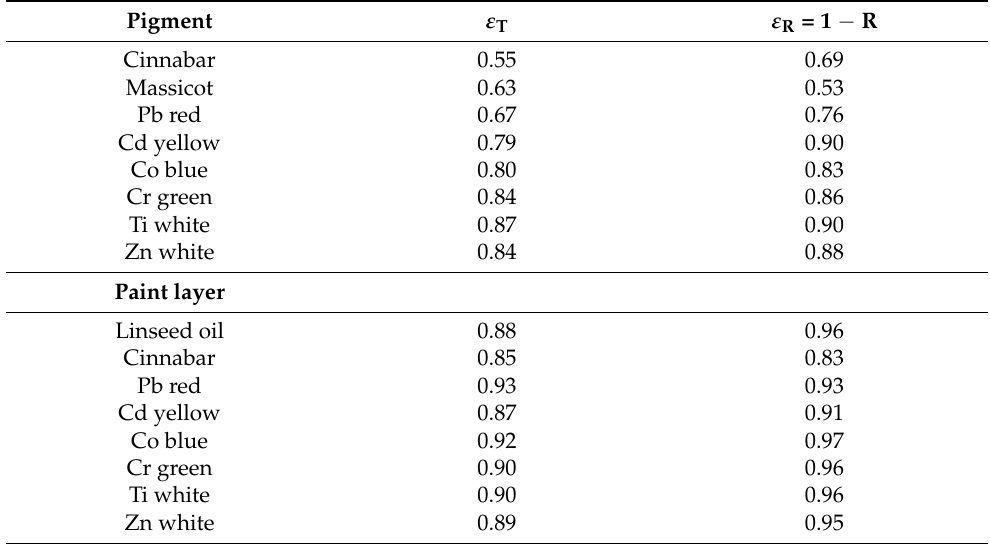
Table 2. Emissivity of pigments (powder) and paint layers with linseed oil binder using the direct ( ε T ) and indirect ( ε R = 1 − R ) method, respectively.